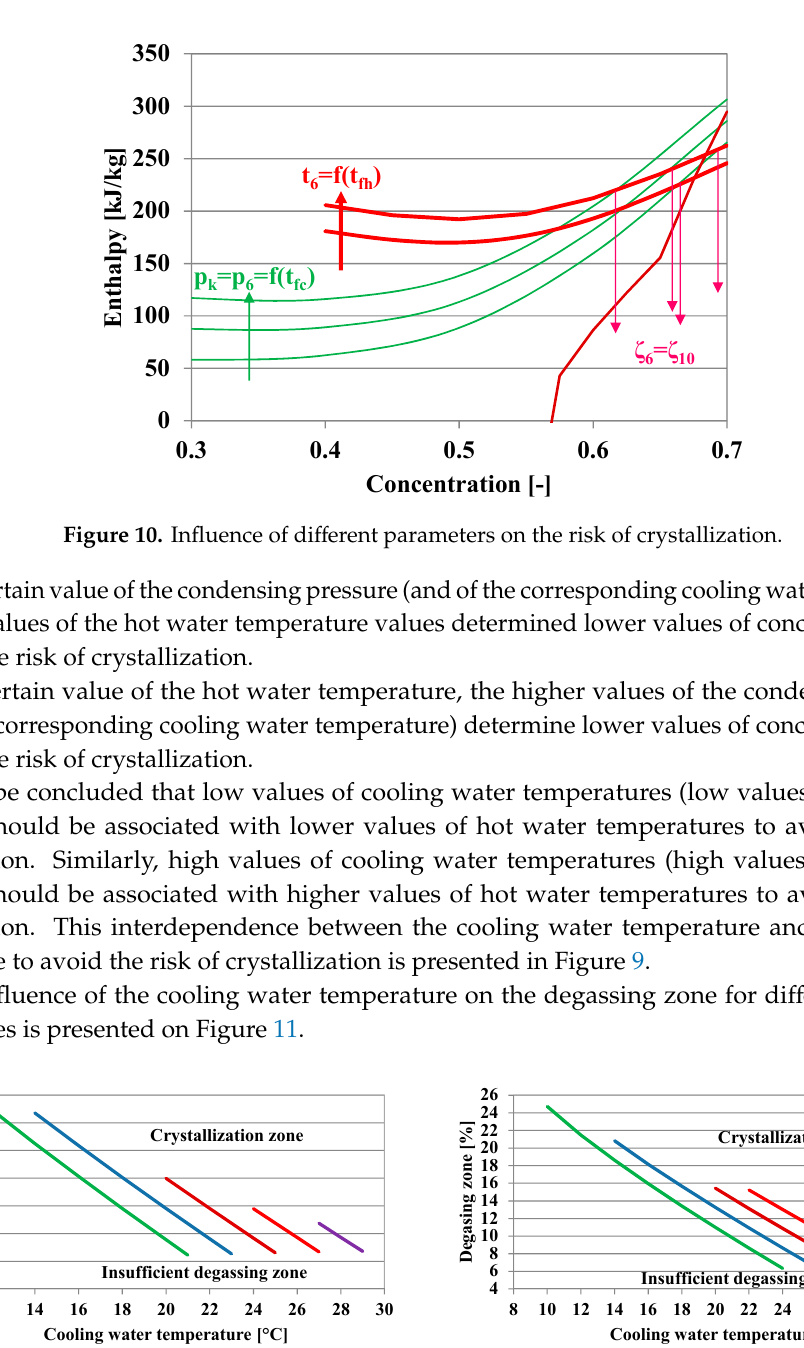
Figure 12. Influence of different parameters on the diluted solution concentration.